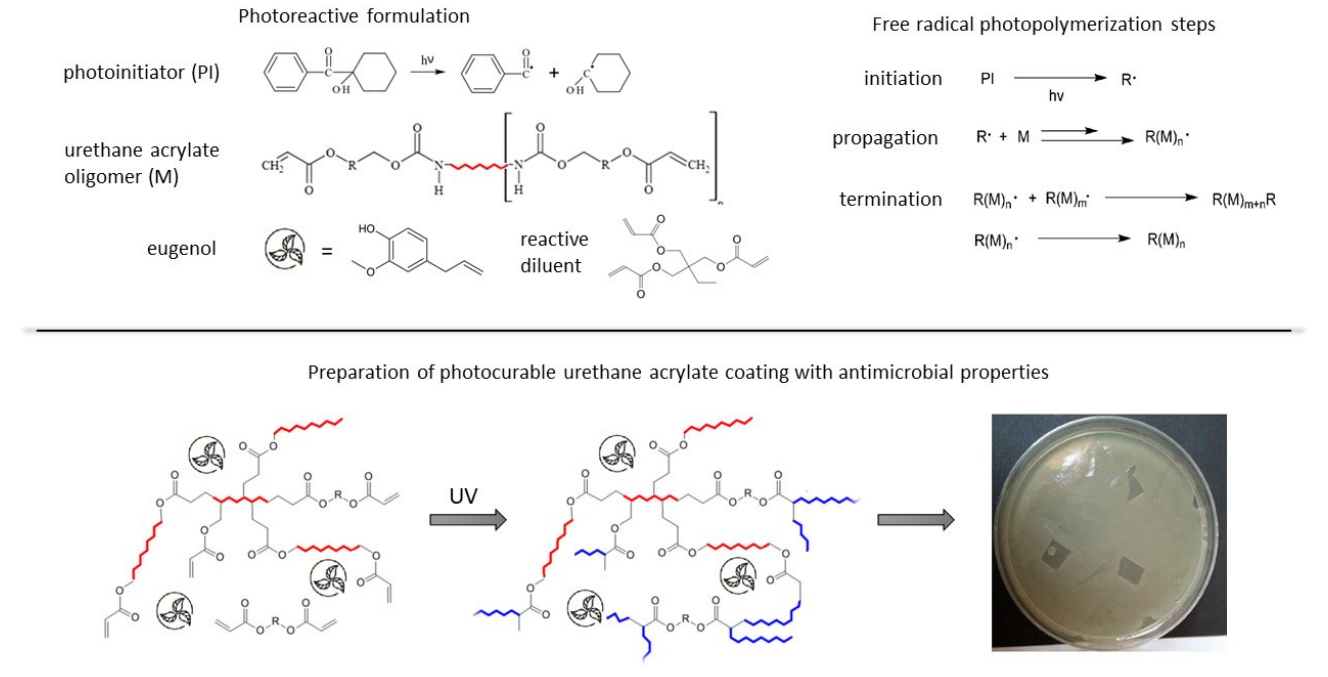
Figure 1. The method of preparing the photocurable urethane acrylate coatings containing eugenol.